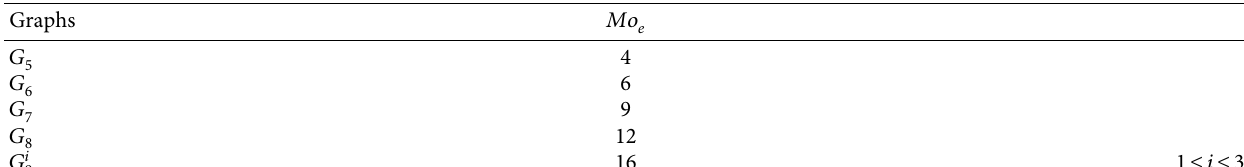
Table 2: The edge Mostar index of graphs in Figure 11.